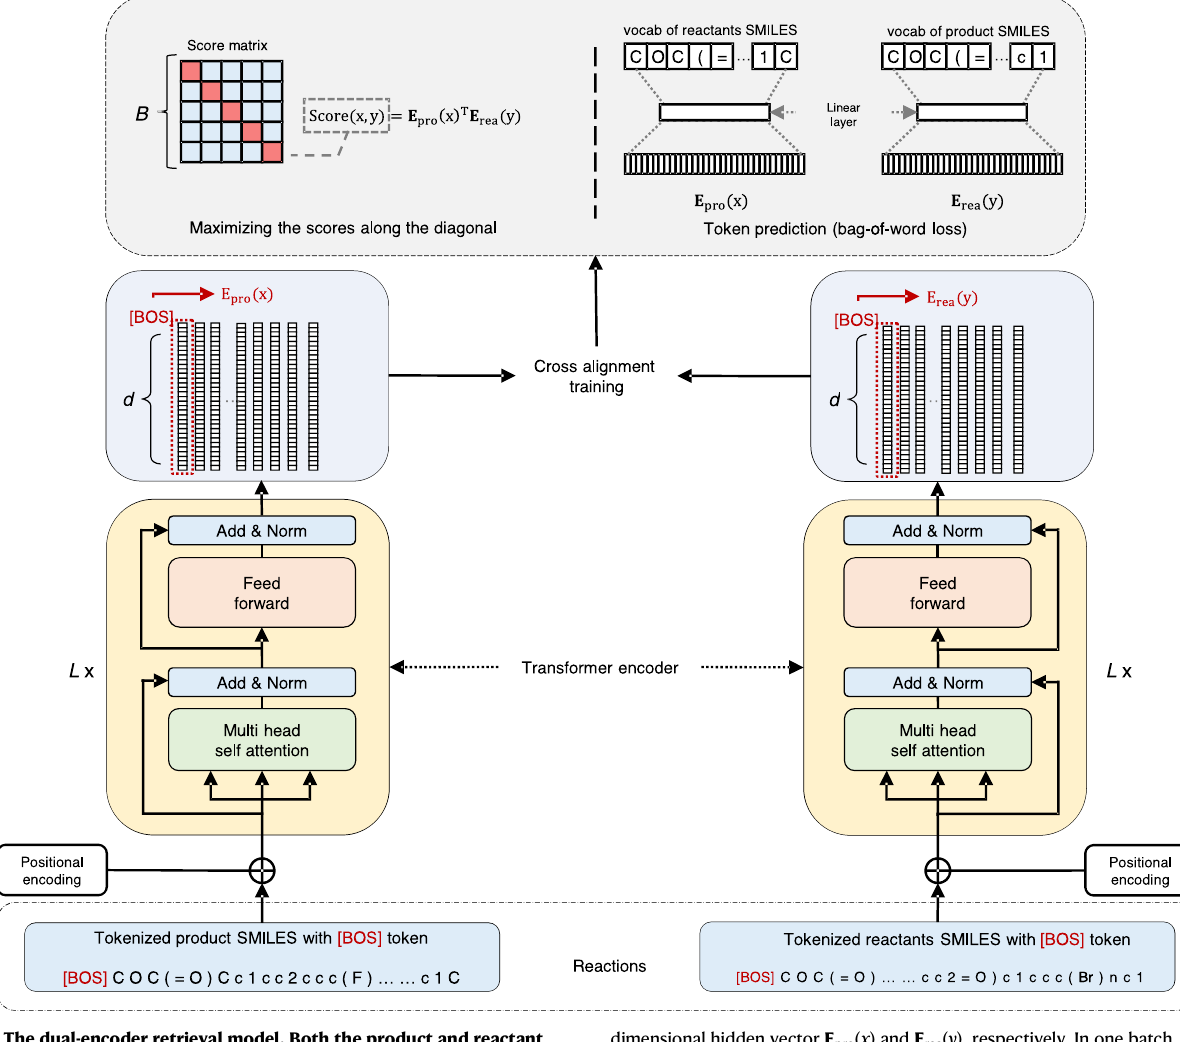
dimensional hidden vector E pro ( x ) and E rea ( y ), respectively. In one batch, the training objective is to maximize the scores along the diagonal of the score matrix and minimize the bag-of-words loss for token-level